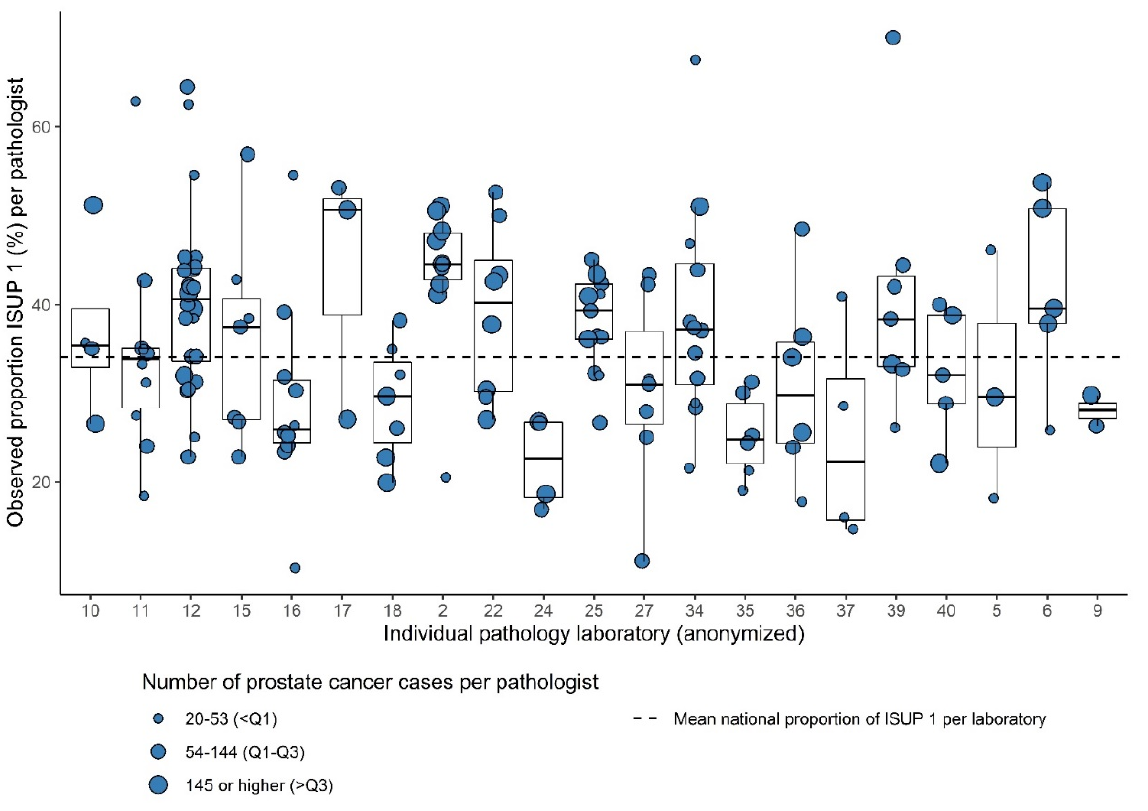
Figure 3. Box plots showing the observed proportion of ISUP Grades 1 versus 2–5 per pathologist (dots) within 21 laboratories relative to the mean national proportion for ISUP grade.